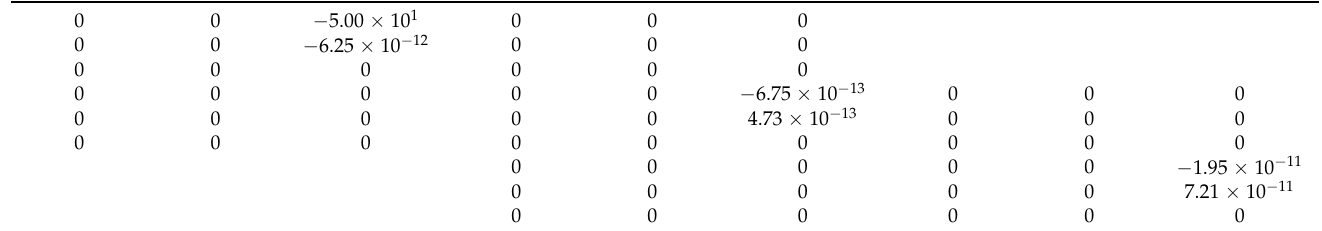
Table 6. Second term K II in the deformed configuration obtained applying F 2 y = 50 ( µ N). T